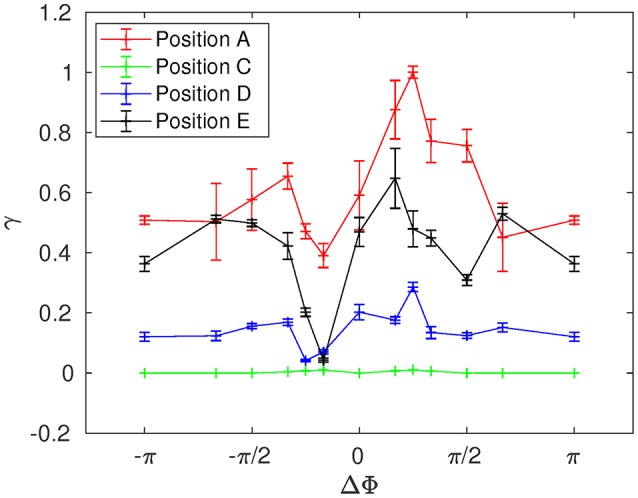
Lyapunov exponent γ as a function of the phase lag ΔΦ for Re = 5.10−2 at positions A, C, D, and E.